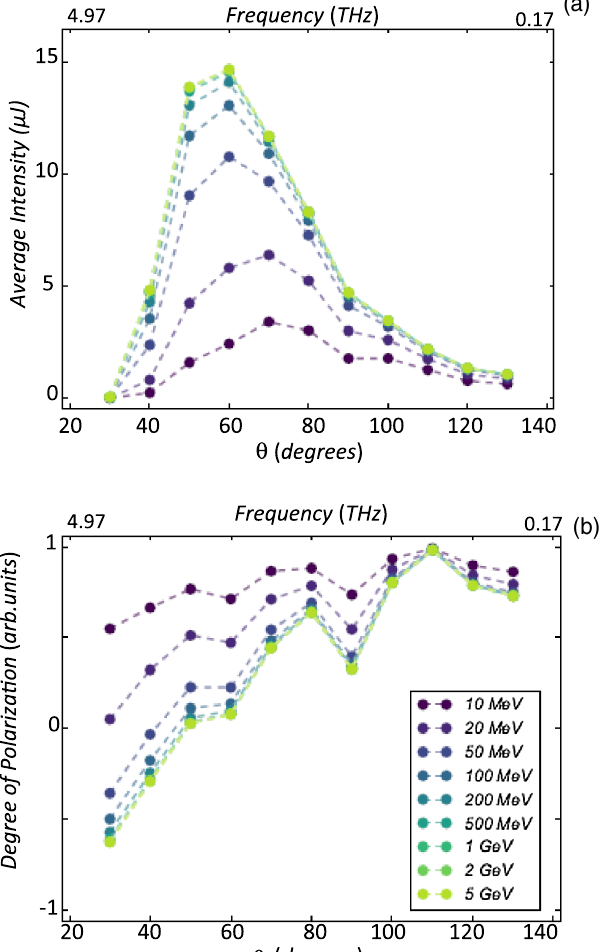
FIG. 10. The figures show the calculated (a) average intensity and (b) DoP of cSPr measured for varying detector acceptance apertures. The markers on each graph represent the location of the detectors along the θ coordinate (all detectors are located at φ ¼ 0 ). The values given for the average intensity are in μ J and have been obtained by integration over the given aperture [see inset of